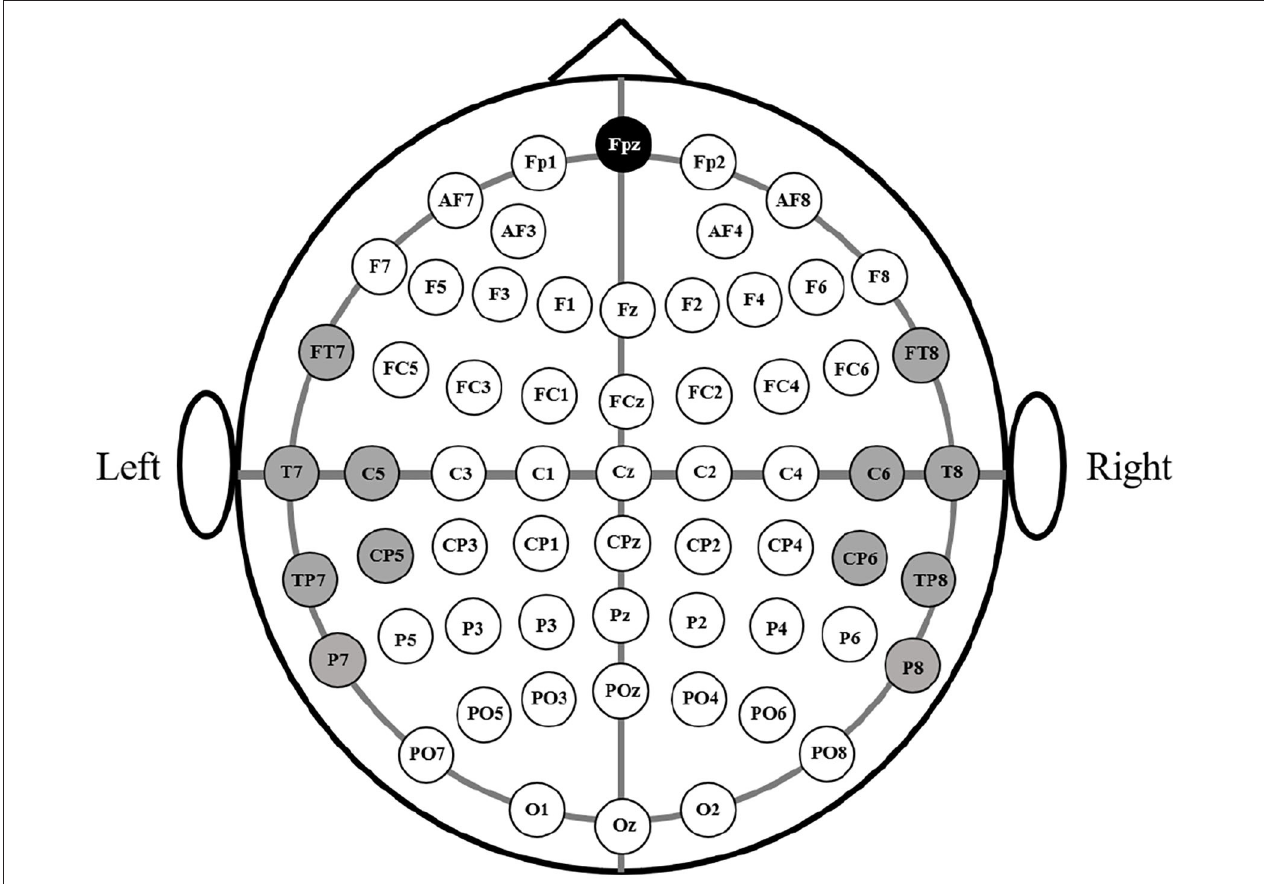
FIGURE 5 | The positions of the electrodes according to the international 10–20